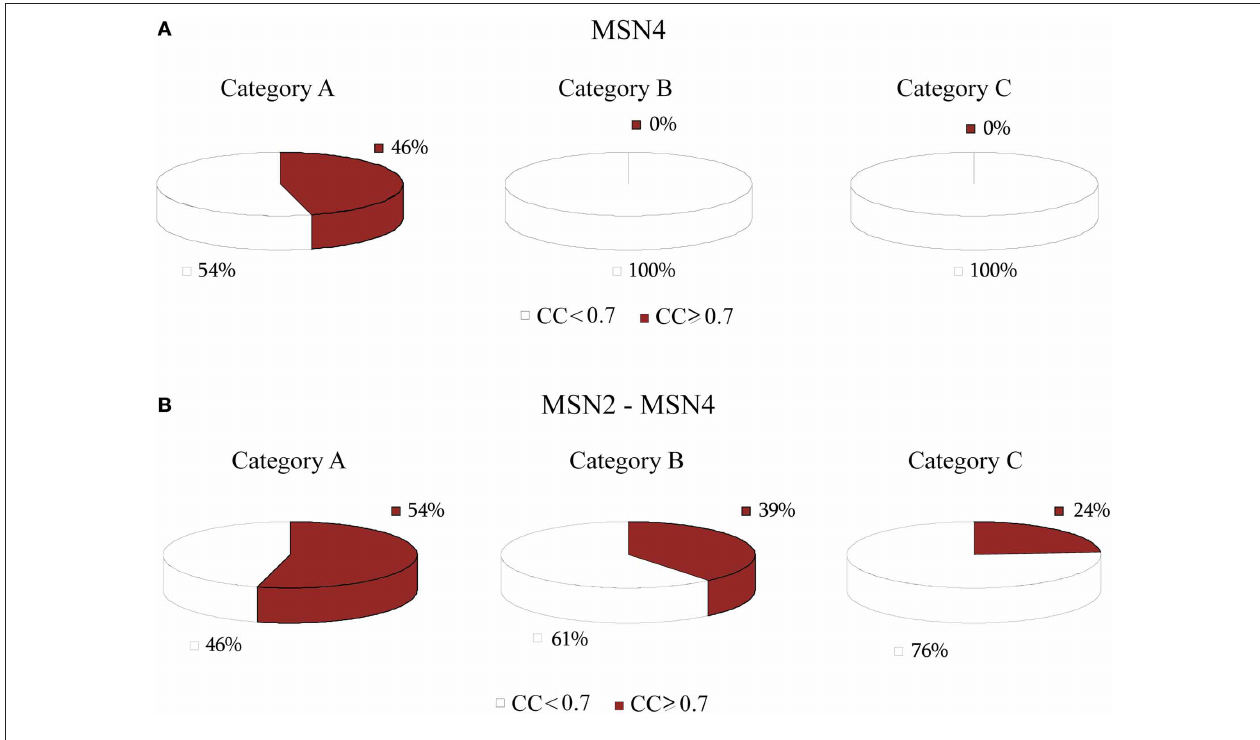
FIGURE 10 | Pie charts that show the grouped correlation coefficients (CC) of the ANN models in the three stress categories. (A) Results correspond to genes in modules regulated by MSN4 alone. ANNs with CC > 0.7 are only seen in Category A (heat shock) whereas no good predictions